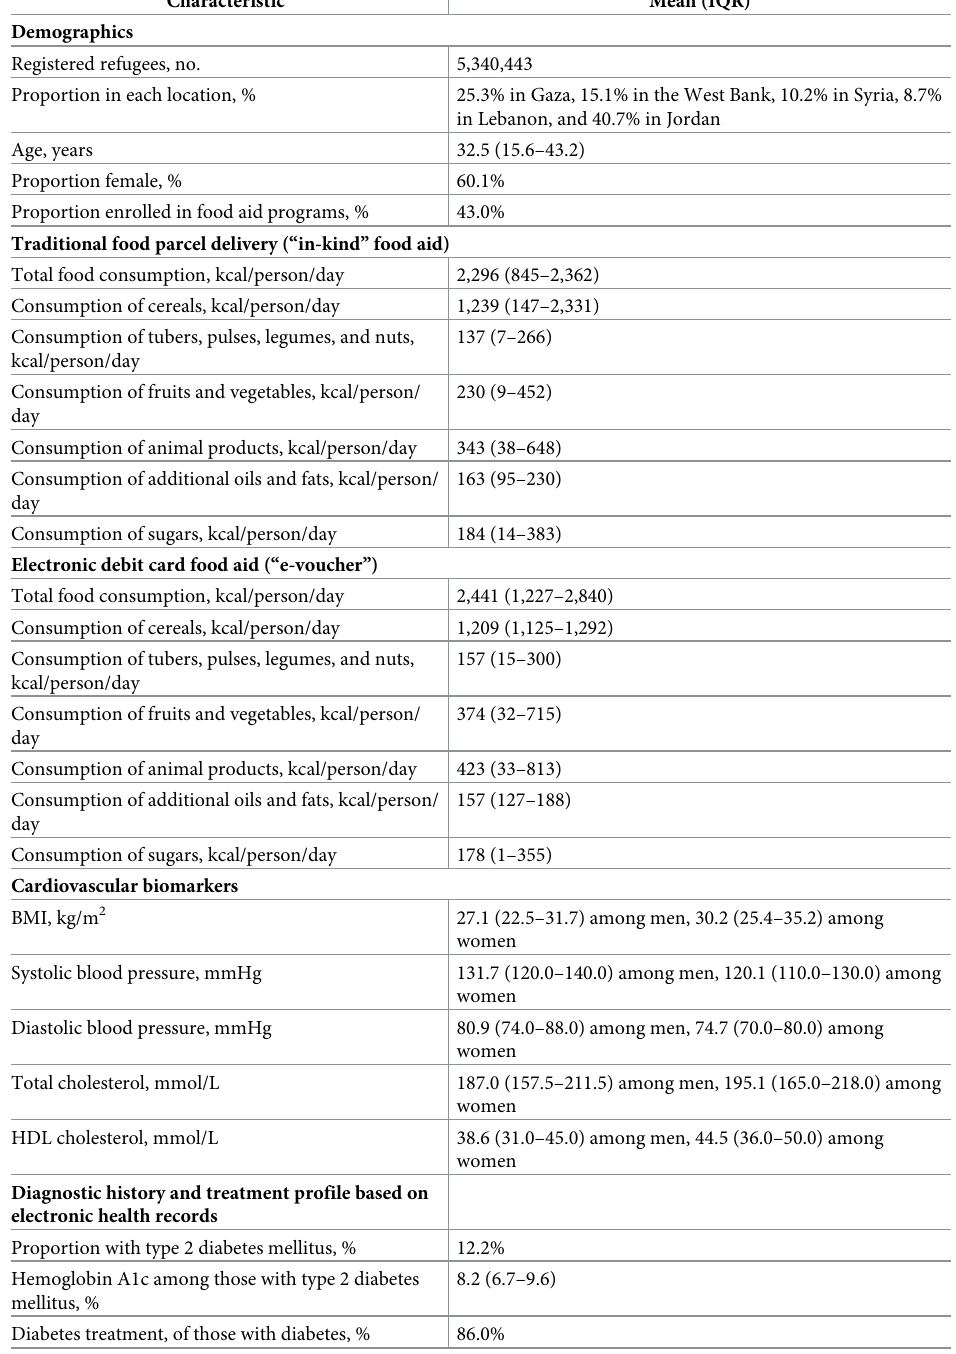
Table 1. Demographic, food consumption, and health data from Palestinian refugees in the Middle East. Demo- graphic data from the UN ( n = 5,340,443; 2017), food consumption data from the World Food Program ( n = 2,554 households; 2011–2017), and health data from UNRWA ( n = 516,386; 2012–2015), specifically from the electronic health record that is believed to be comprehensive given universal refugee registration procedures that establish a pop- ulation denominator for each estimate [15,16,26].The data are from pilot studies conducted among the affected popu- lation in community-based settings to specifically address how much (or how little) responsiveness occurs in the context of food availability in refugee cities and